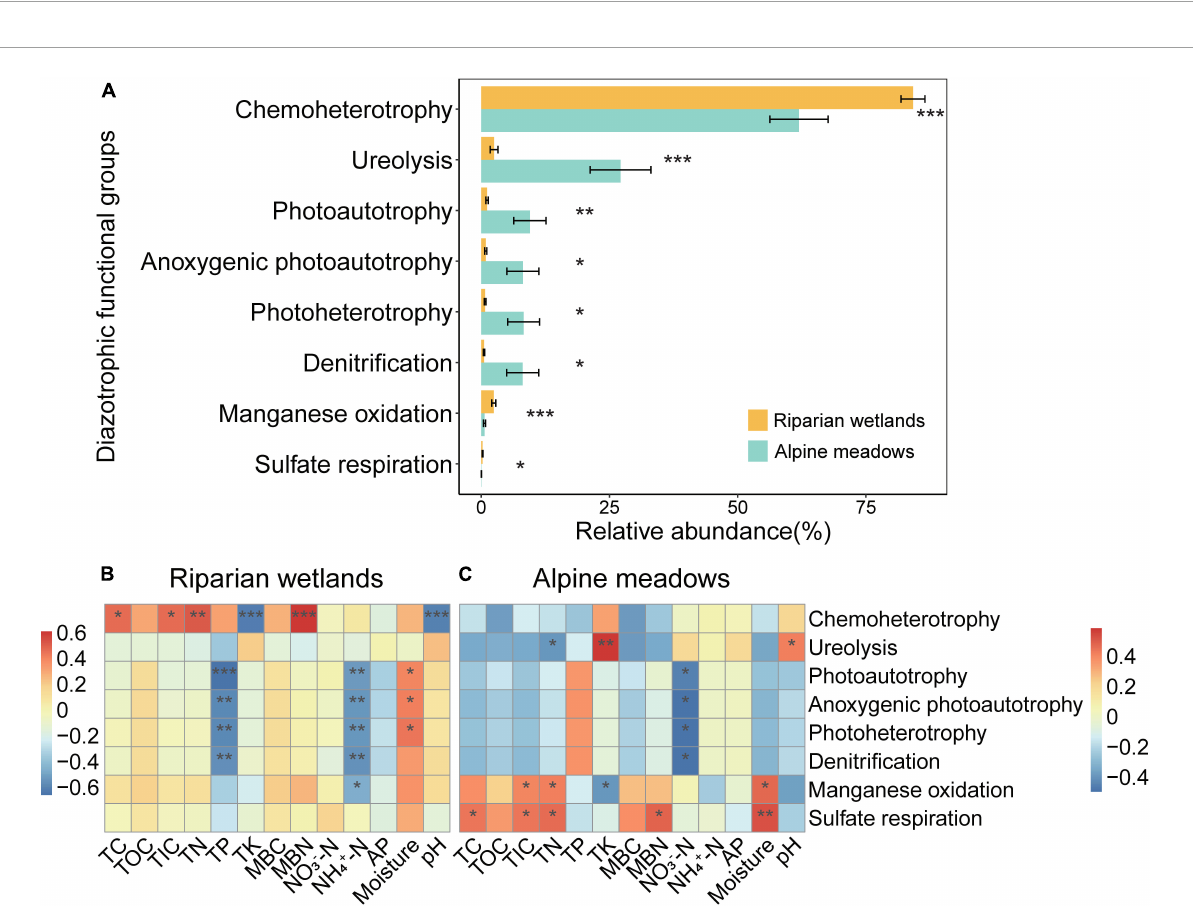
FIGURE4 The functional profiles of soil diazotrophic communities. (A) The relative abundance of diazotrophic functional groups in the riparian wetland and alpine meadow soils. Only the functional groups showed significant differences are shown. All the data were presented as mean ± SE. (B) The relationships between the relative abundance of soil diazotrophic functional groups and soil properties in the riparian wetlands. (C) The relationships between the relative abundance of soil diazotrophic functional groups and soil properties in the alpine meadows. TC, soil total carbon content; TOC, soil total organic carbon content; TIC, soil total inorganic carbon content; TN, soil total nitrogen content; TP, soil total phosphorus content; TK, soil total potassium content; MBC, soil microbial biomass carbon content; MBN, soil microbial biomass